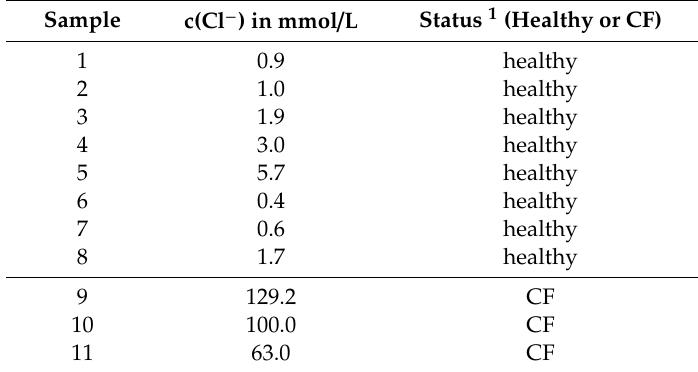
Table 3. The determined chloride concentration of sweat samples and categorization in health status.